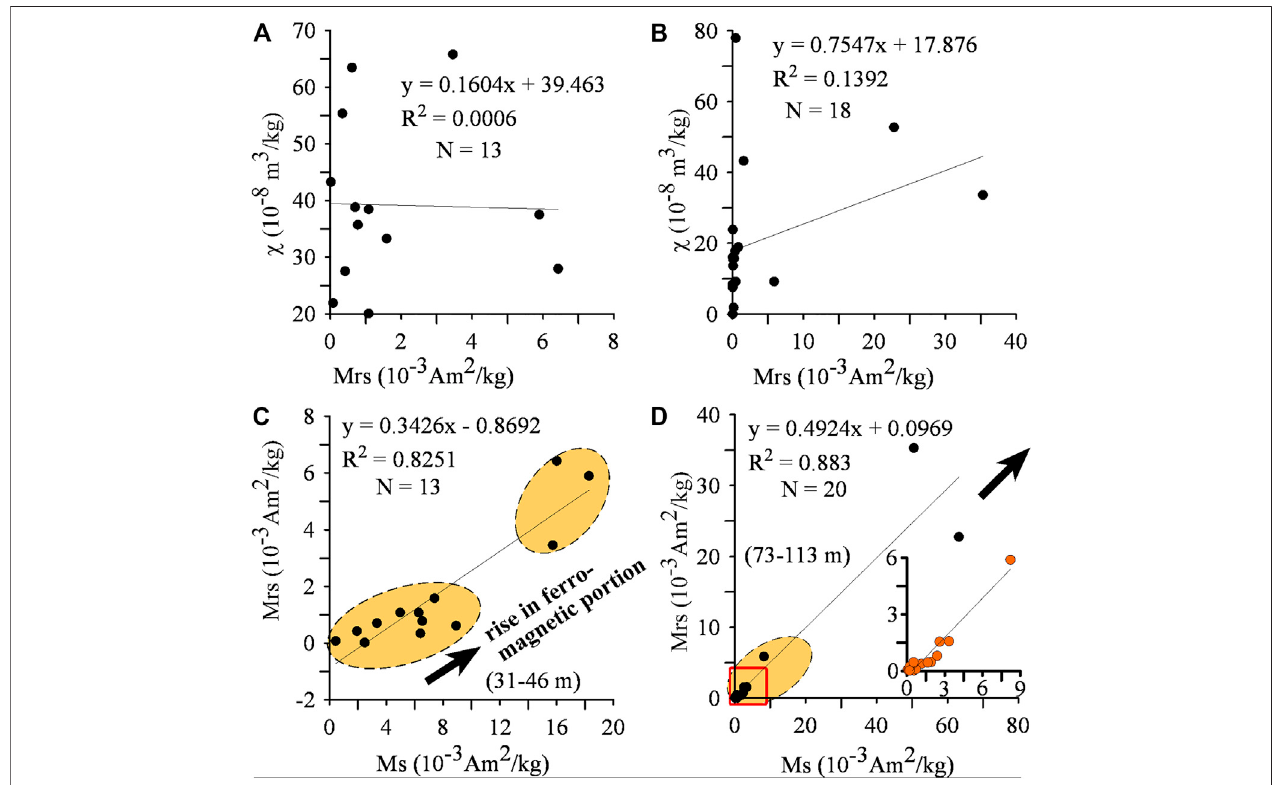
FIGURE 8 | (A-B) Bivariate plot of χ versus Mrs, a very low linear relation among both the concentration dependent. (C-D) Linear relation between Ms and Mrs display the magnetic mineral concentration for marine environment (31 – 46 m and 73 – 113 m).